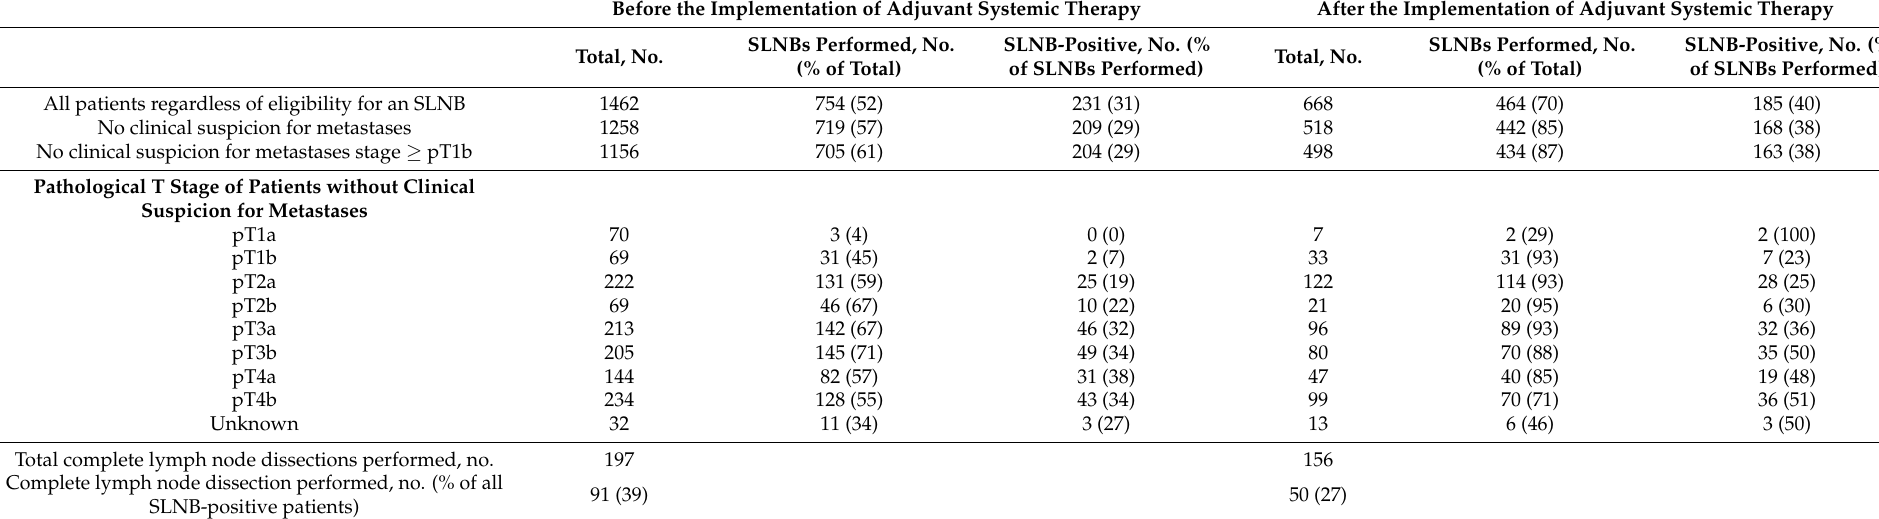
Table 2. Sentinel lymph node biopsies (SLNBs) performed before (2014–2018) and after (2019) the implementation of adjuvant systemic therapy, and the proportion of patients with positive macro-metastasized lymph